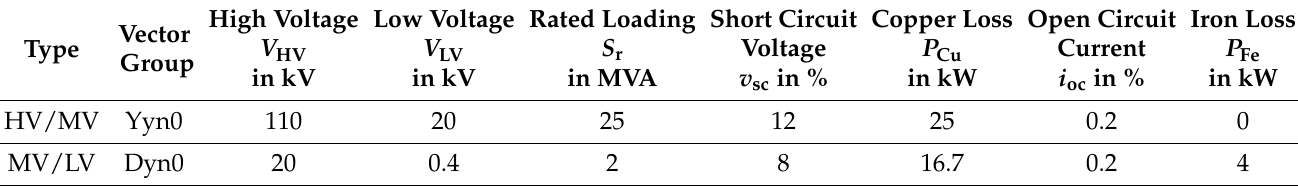
Figure A1. Structure of the Cigré medium voltage (MV) benchmark grid. Table A1. Transformer data of the Cigré MV benchmark grid.